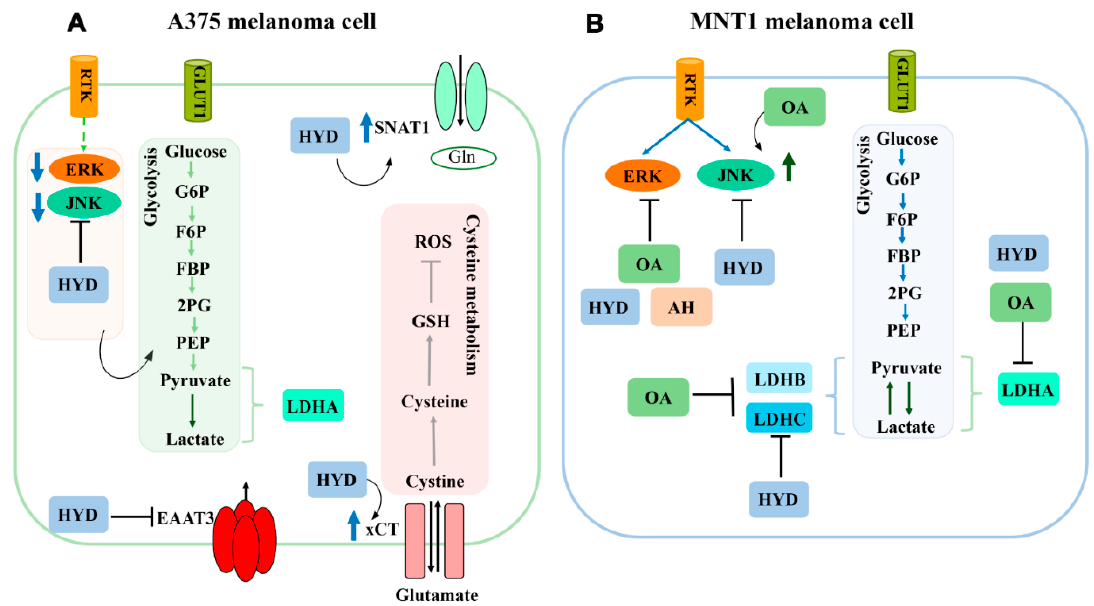
Figure 4. Schematic illustration summarizing the specific effects of oleic acid (OA), homovanillyl alcohol (HA), and hydroxytyrosol (HYD) on key metabolic pathways activated in A375 and MNT1 melanoma cell lines. ( A ) Hydroxytyrosol treatment seems to have a significant effect on A375 cells, reducing total JNK and phosphorylated ERK levels, and consequently decreasing the glycolytic rate via PKM2 inhibition. This compound also increased SNAT1 and xCT expression, probably in order to activate alternative mechanisms of energy production and detoxification in an attempt to resist the cytotoxic stimulus induced by hydroxytyrosol. EAAT3 downregulation could suggest that these cells are less dependent on the transport of L -glutamate, L -aspartate, and D -aspartate. ( B ) In MNT1 cells, hydroxytyrosol also reduced total JNK and phosphorylated ERK levels. In addition, homovanillyl alcohol and oleic acid decreased ERK phosphorylation. The glycolytic rate of this melanoma cell line was also affected by hydroxytyrosol and oleic acid treatments.